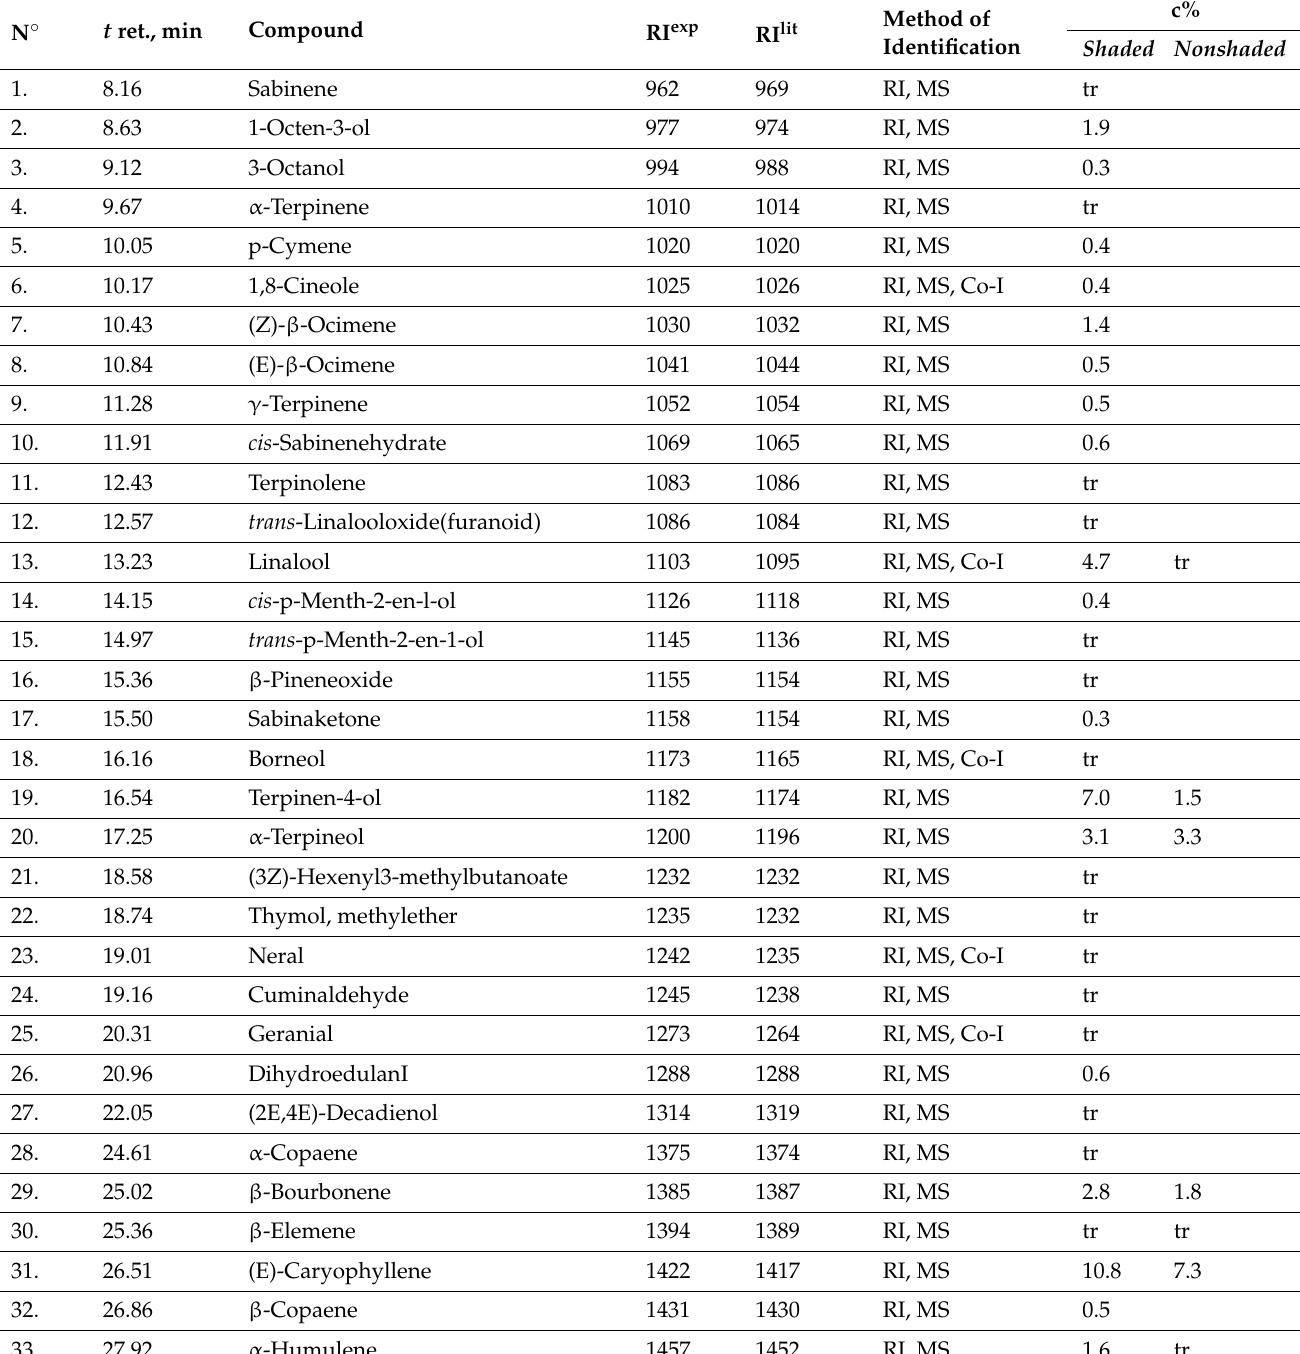
Table 4. Chemical composition of essential oils isolated from shaded and nonshaded oregano